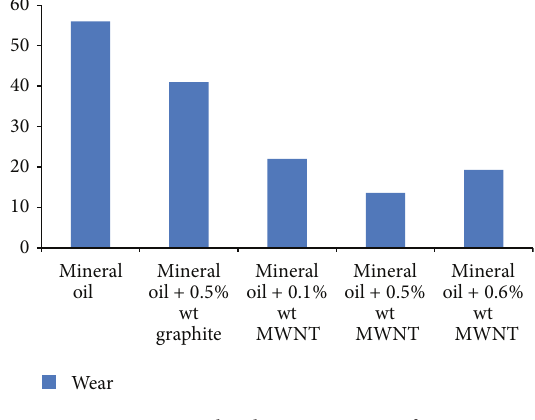
Figure 8: Graphical representation of